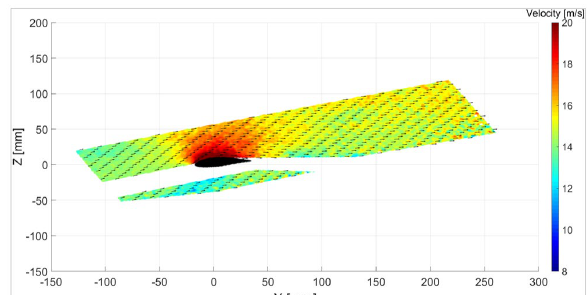
Figure 7. Instantaneous flow field around model wind turbine blade in reference coordinate system